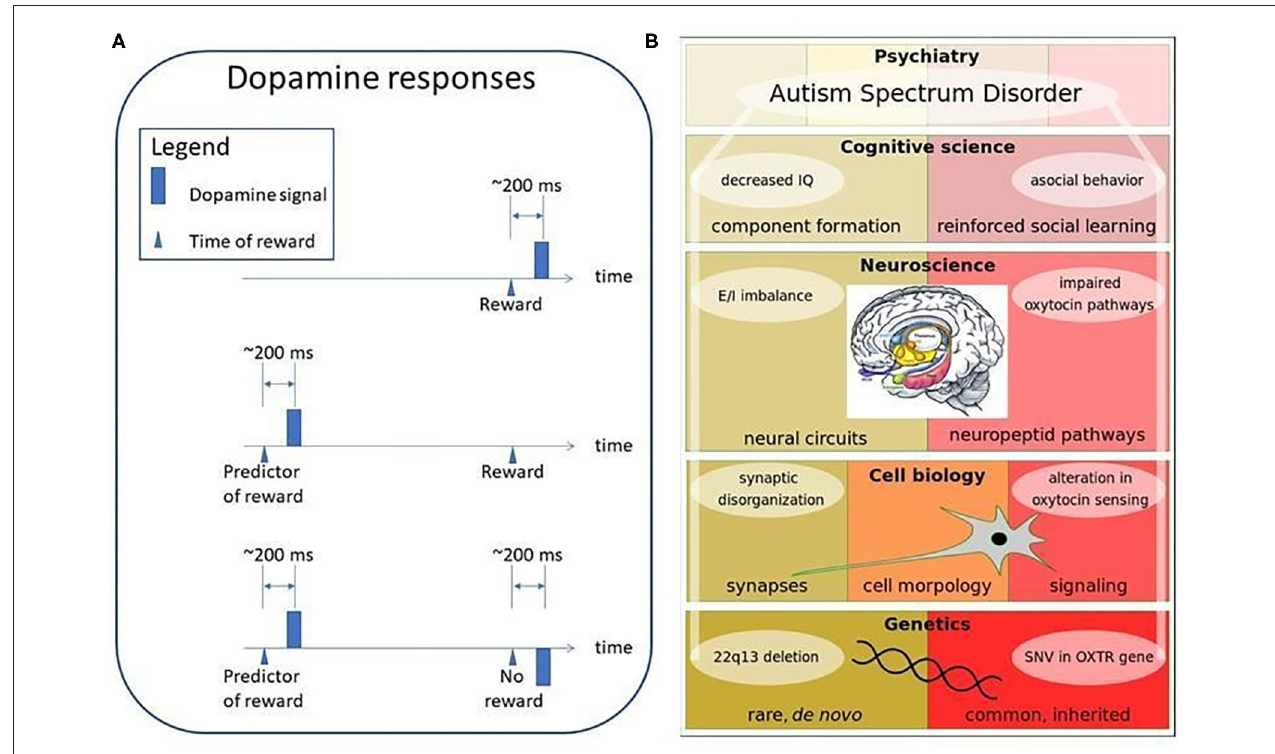
FIGURE 7 | Dopamine responses and ASD stratification possibilities. (A) Dopamine responses. Dopamine signal emerges for reward, first. If the reward predicting feature is learned, then dopamine signals only for the predictive feature upon learning. If a predictive signal is present, but the reward is missing, then a negative dopamine signal appears at the time of the reward (60, 62). Mechanism in the striatal region is the same for processing either social or non-social rewards being aberrant in ASD individuals (63). (B) Examples of ASD stratification possibilities. Causes of ASD can be separated on different levels of biology (genetics, cell biology, neuroscience, cognitive science). These levels are built on each other and form causative pathways. Two examples are shown: (left hand side): the component formation related Phelan-McDermid syndrome ( 64), which is defined by a de novo 22q13 deletion as the genetic cause and synaptic disorganization, E/I imbalance and decreased IQ as consequences; (right hand side): the reinforced social learning related oxytocin system, where common, inherited SNVs in the OXTR gene could be a genetic cause and altered oxytocin sensing, impairments of the oxytocin pathway and asocial behavior as the consequences. Inset is from Sokolowski and Corbin (65) under a CC license. Color notation in the inset is as follows: amygdala is green, bed nucleus of stria terminalis (BNST) is light blue, hypothalamus (Hypo) is yellow, hippocampus (Hipp) is pink, mammillary bodies are orange, olfactory bulbs (MOB) is purple, amygdala is green, gray smaller regions are nucleus accumbens (NuAc), periaqueductal (PAG), and ventral tegmental area